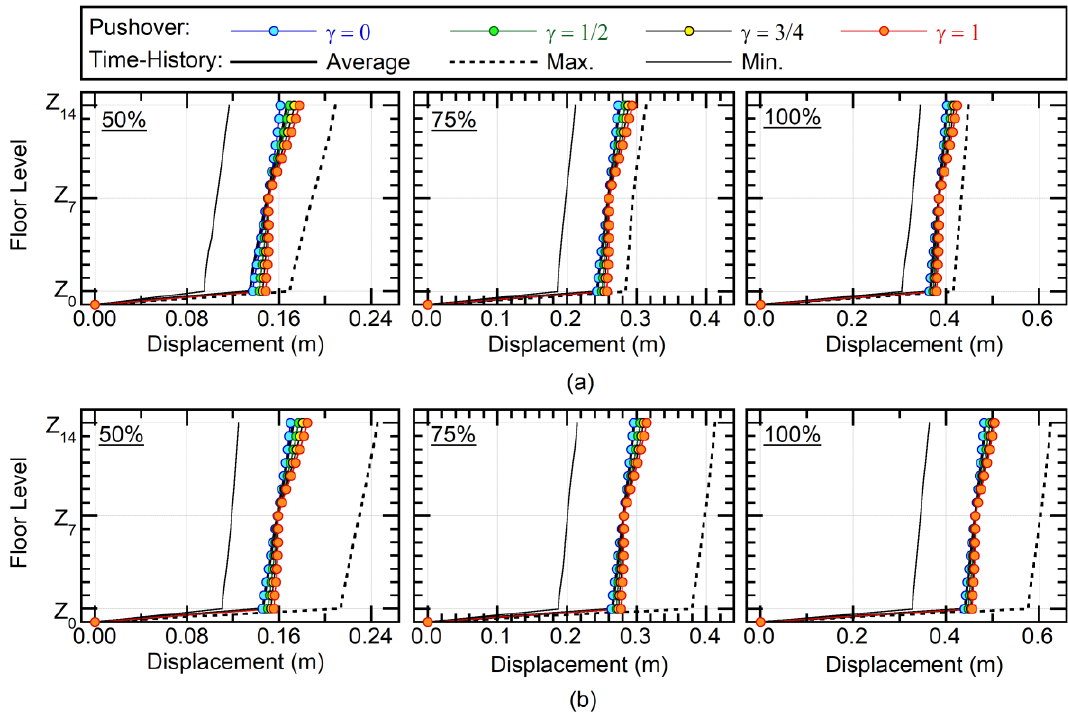
Figure 18. Comparison of the peak relative displacement of Model-14: (a) Art-S series and (b) Art-L series.